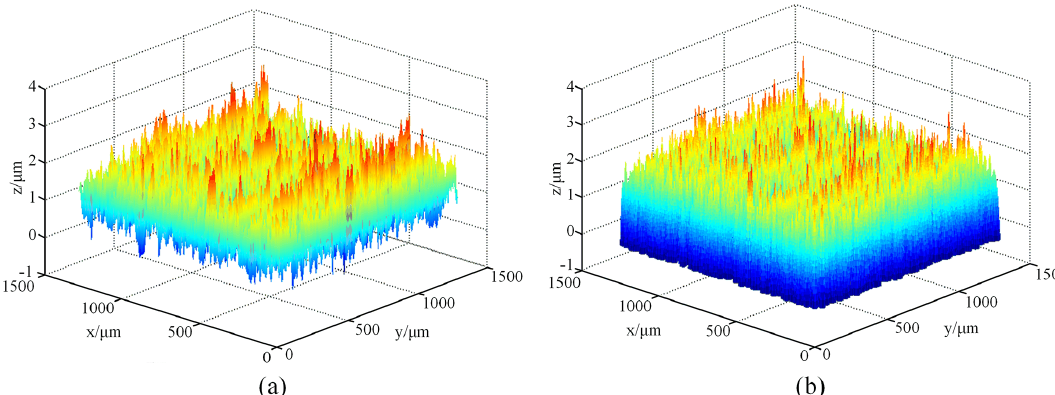
Figure 7. Typical 3D topographies of turning specimens. (a) Measured surface. (b) Watershed and fitted.